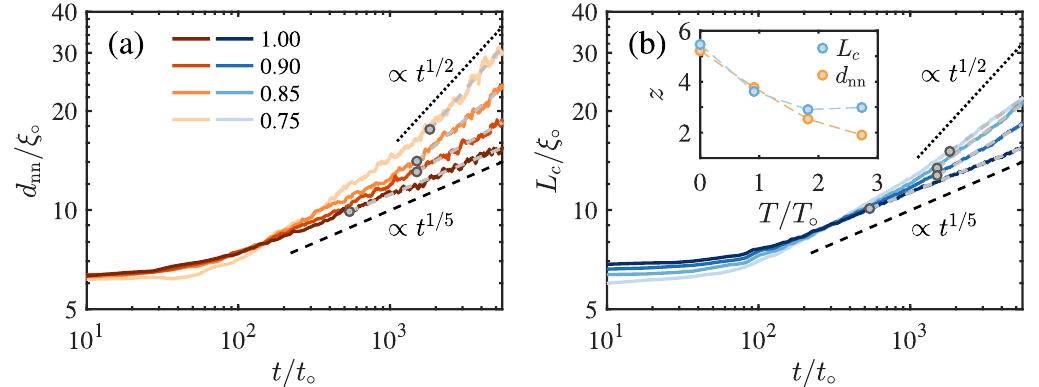
Figure 6: (a) Mean nearest-neighbour vortex distance d L , as functions of time for all four initial condensate temperatures. Power-law fits to c each curve are shown as grey dashed lines, with the start point of each fit indicated by a grey dot. For comparison, the power-laws corresponding to the two fixed points, discussed in Ref. [ 54 ] , are shown as dashed ( t 1 both frames. The inset of (b) shows the measured dynamical critical exponent z from each fit as a function of